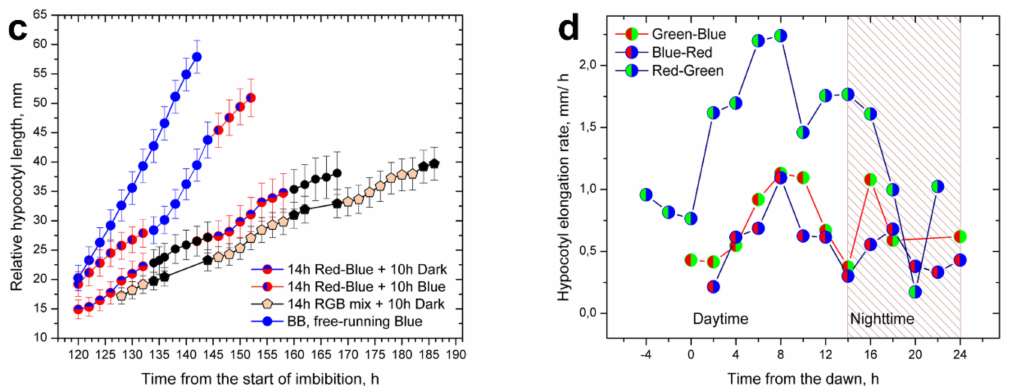
Figure 4. Alternating and simultaneous application of monochromatic light. ( a ) Hypocotyl elongation in a photoperiod in which 14 h long periods of yellow light alternated with 10 h long periods of blue light. In each of the periods, non-suppressive hypocotyl elongation was an independent event that followed its own rules. ( b ) Four hour long T-cycles in which red or blue light alternated with darkness, which was not suppressed by previous blue or red light illumination. Blue periods following darkness had low initial elongation rates that later improved. ( c ) Hypocotyl elongation in treatments with a suppressive red + blue dual illumination followed by true darkness or blue light. Suppressive red + blue light continued to suppress elongation in the following period of true darkness but not in the blue light. Therefore, darkness remained suppressive after the red + blue doublet, whereas blue light promoted hypocotyl elongation after red + blue. ( d ) Hypocotyl elongation in plants illuminated for 14 h with three distinct RGB doublets followed by 10 h periods of darkness. High hypocotyl elongation was promoted only in the blue + green doublet, which lacked the early night peak found in white light diurnal